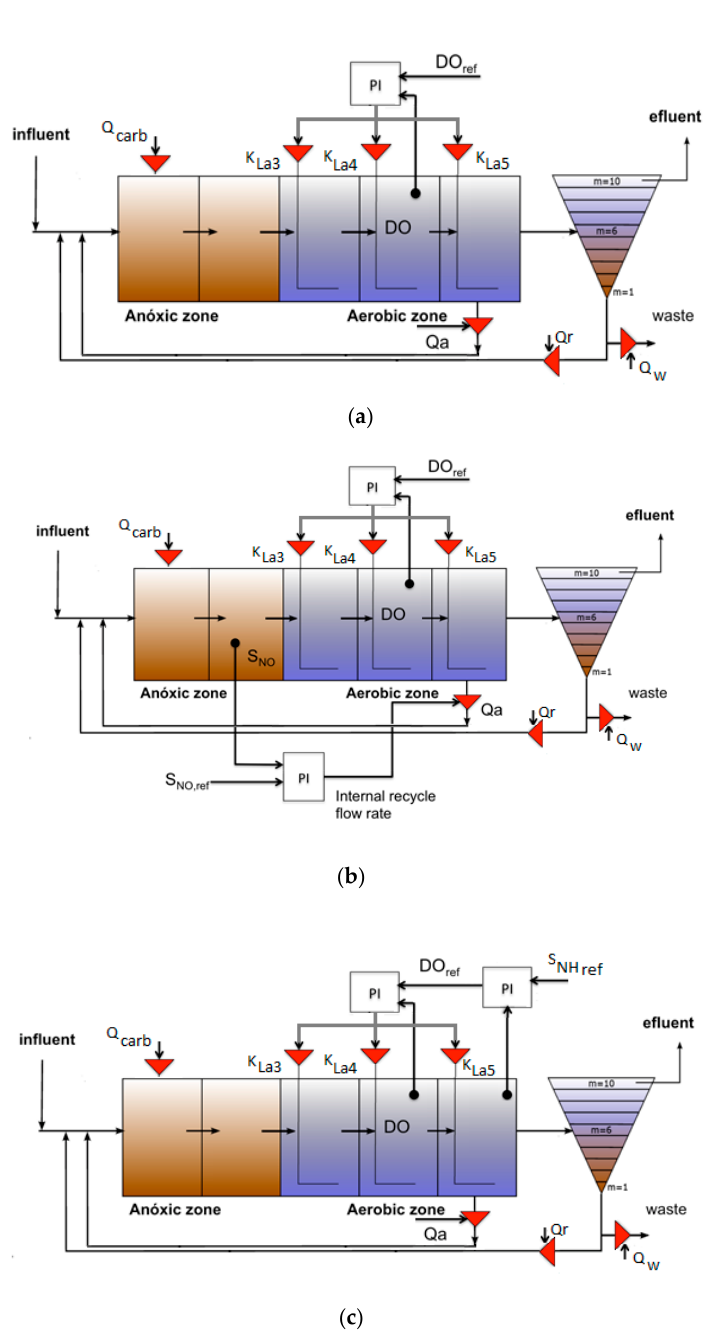
Figure 2. Operation strategies applied to BSM2 platform. ( a ) BSM2 Default operation strategy (dissolved oxygen (DO) default), ( b ) BSM2 Default operation strategy with nitrates control scheme (DO + nitrates control (NO)), ( c ) BSM2 Default operation strategy with ammonium-based control scheme (Cascade S NHSP ).